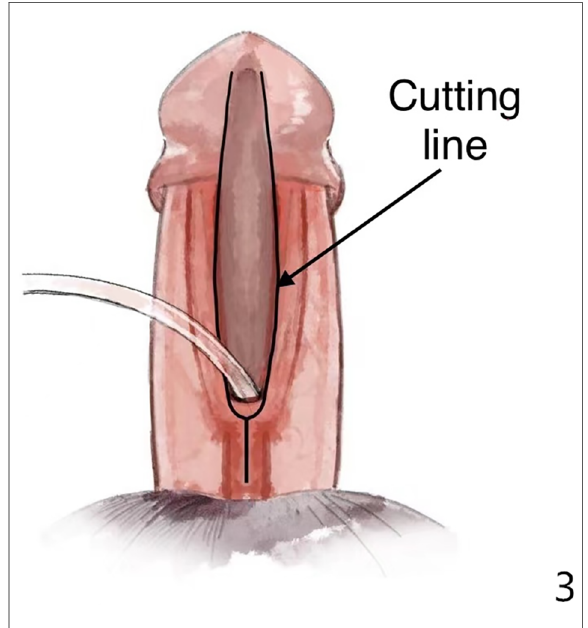
FIGURE 3 We separated Buck ’ s fascia and glans wings along the black line in the fi gure. The divergent spongiosum lying on Buck ’ s fascia was preserved. The urethral corpus cavernosum and Buck ’ s fascia were separated together.